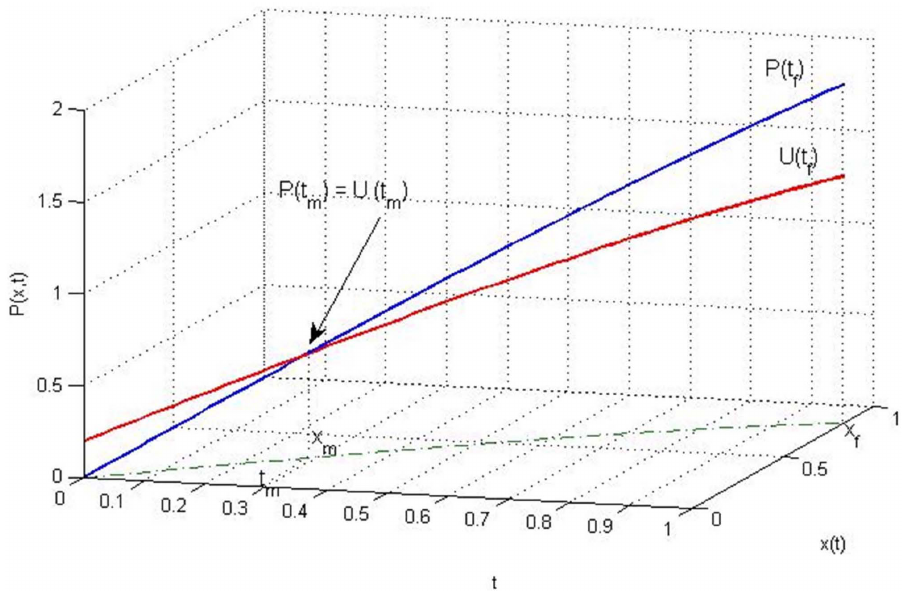
Figure 2. Trajectories of P ( t ) and U ( t ) .